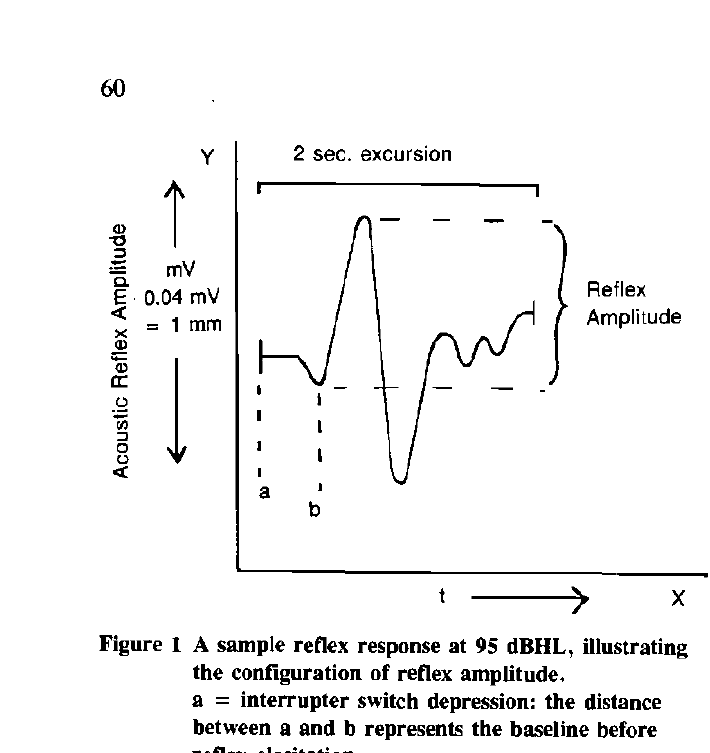
Figure 1 A sample reflex response at 95 dBHL, illustrating the configuration of reflex amplitude, a = interrupter switch depression: the distance between a and b represents the baseline before reflex elecitation.